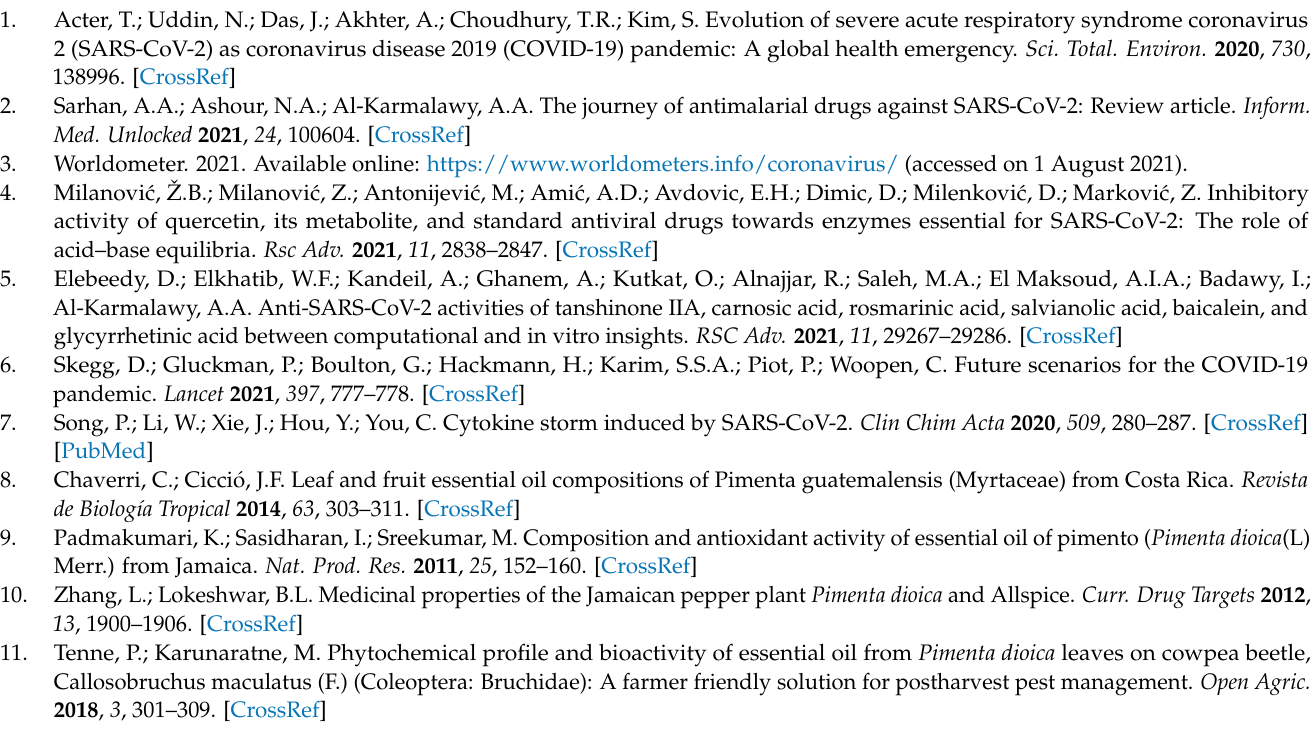
Figure S1: Superimposed poses of the docked N3 inhibitor ( 5 ) (represented in green color) over the native co-crystallized one (represented in red color) inside the Mpro binding pocket (from Table 3). Above (2D) and below (3D) graphical representations, SI3: Methodology of RP-HPLC analysis, SI4: Methodology of molecular dynamics simulations, SI5: Methodology of inhibitory concentration